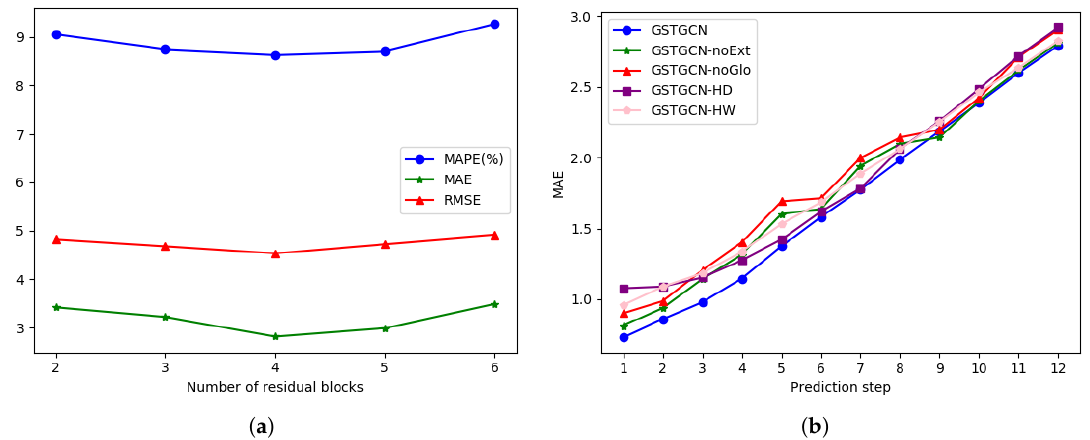
Figure 10. ( a ) Prediction performance of GSTGCN with a different number of residual blocks on PeMSD7. ( b ) MAE of each prediction step of GSTGCN and its four variants on